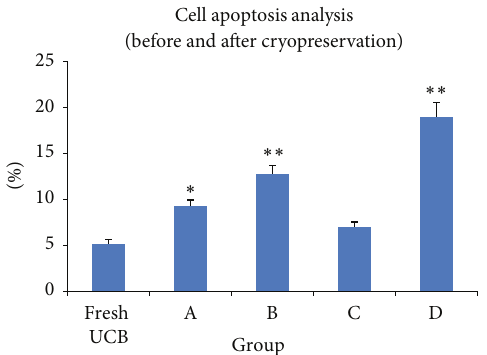
Figure 4: The cell apoptosis of group C was lower than that of group A ( 𝑃 < 0.05 ) or groups B, D ( 𝑃 < 0.01 ) after